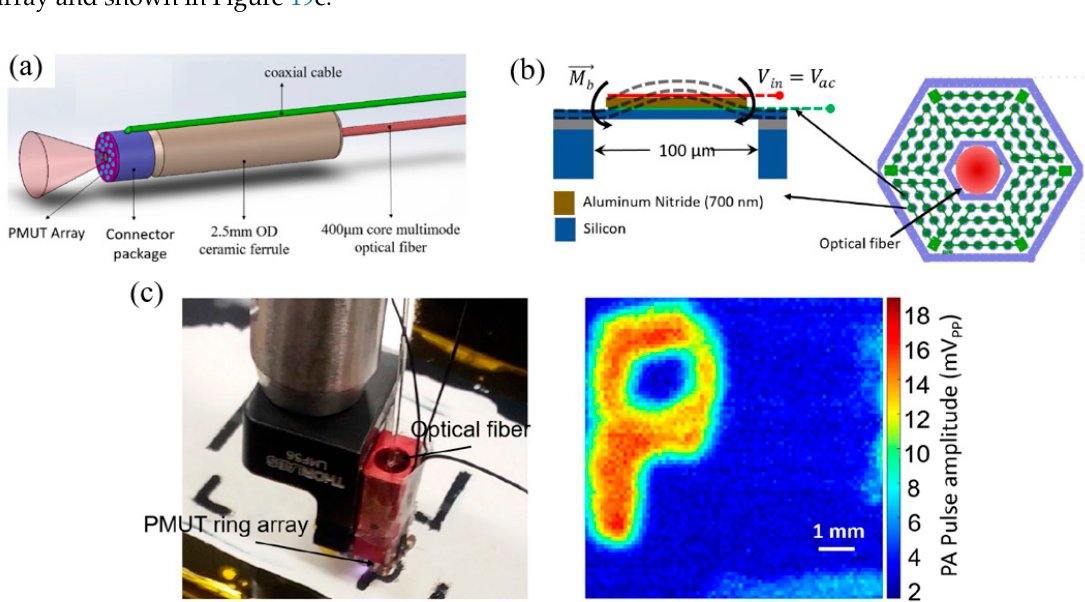
Figure 19. ( a ) Assembly drawing of the miniaturized PAI probe with the pMUT ring array and an optical fiber integrated. ( b ) Schematic of a pMUT cell and the ring pMUT array. ( c ) Photoacoustic imaging experimental setup (left) and the reconstructed image showing the predefined pattern ”P” (right) (Reproduced with permission from SPIE [124]).